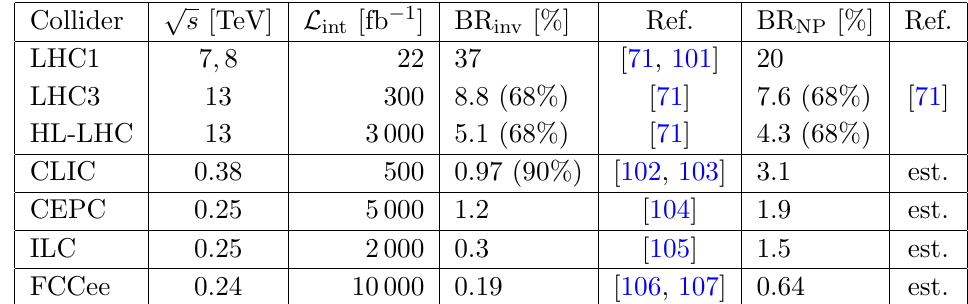
est. p s for benchmarks of